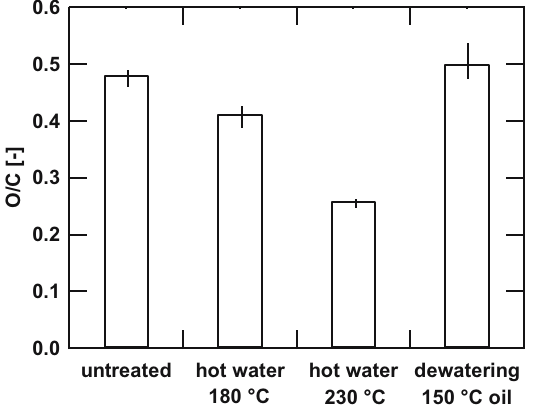
Figure 1: Changes in the O/C atomic ratio of the co ff ee grounds after the hot water treatment or